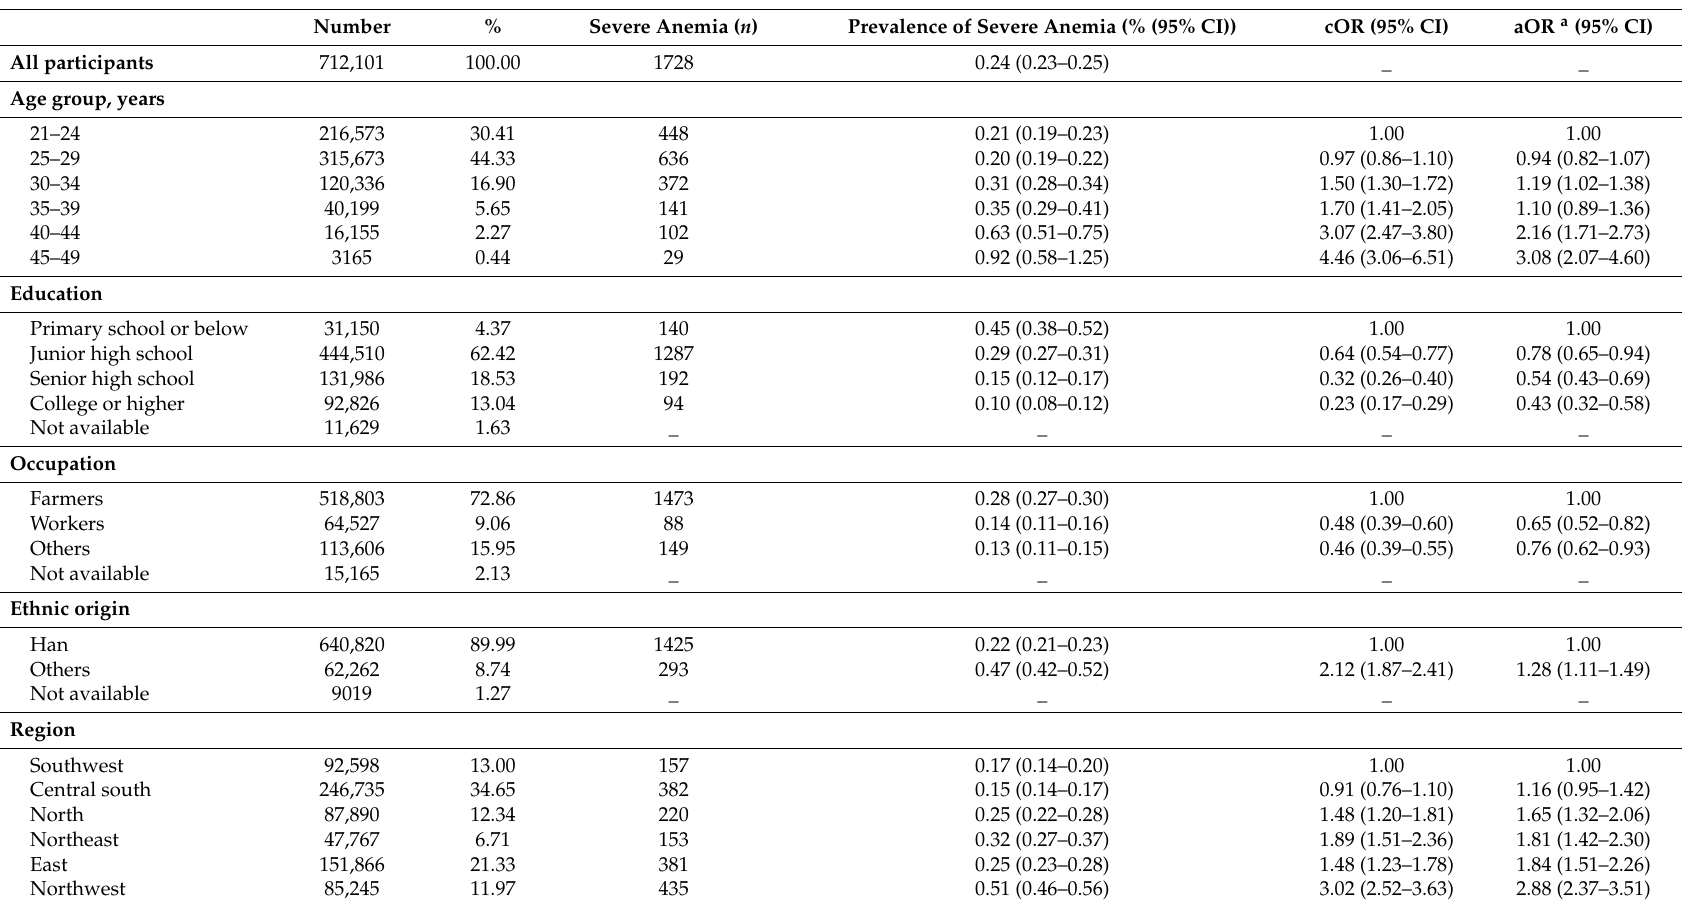
Table 1. Demographic characteristics and severe anemia prevalence among non-pregnant women of reproductive age in 2012, rural China. Number % Severe Anemia ( n ) Prevalence of Severe Anemia (% (95% CI)) cOR (95% CI) aOR a (95%